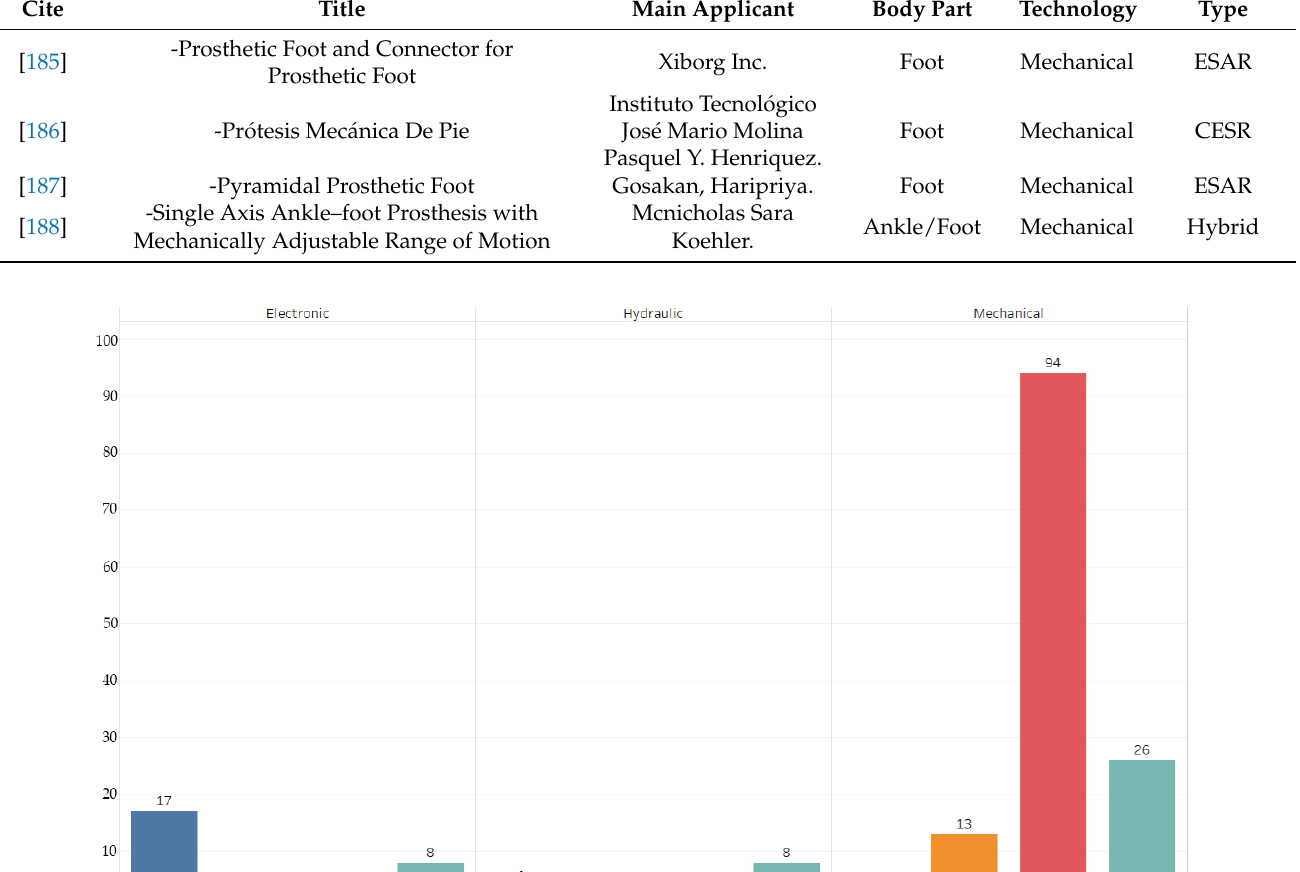
Figure 5. Top patent applicants for lower limb prosthesis.